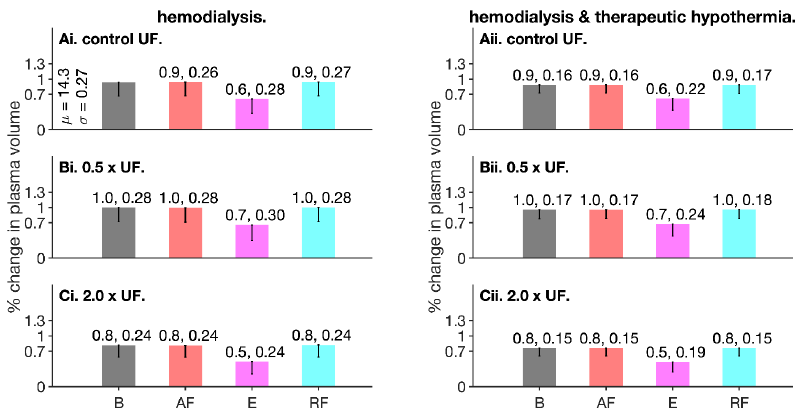
Figure 10. Effectiveness of water volume removal due to HD under multiple conditions and target ultrafiltrate (UF). Left column shows data under hemodialysis conditions, and right column shows data under hemodialysis with therapeutic hypothermia conditions. In all panels, (B gray bars) represents the baseline population, AF (red bars) represents the atrial fibrillation population, E (purple bars) represents the exercise population, and RF (cyan bars) represents the right kidney failure population. All values and standard deviations were normalized to the respective baseline means ( µ ) and standard deviations ( σ ) which are shown besides the gray bar in panel ( Ai